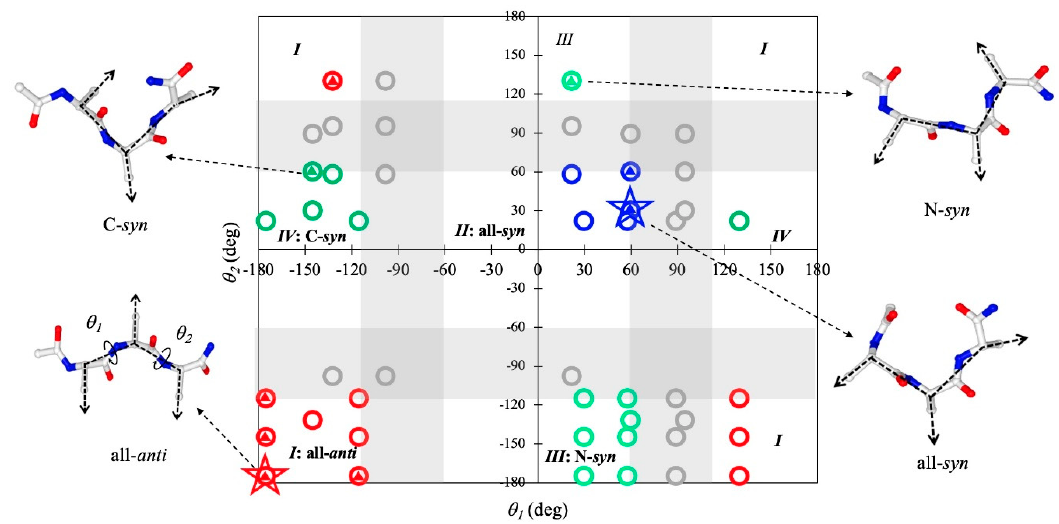
Figure 2. Orientations of sidechains for all the 48 possible conformational states of a tripeptide. The middle plot shows the rotational angles ( θ 1 and θ 2 ) of sidechains for each conformational state. The blue, red, light green, and green circles denote all- syn , all- anti , N- syn , and C- syn conformations, respectively, and the gray circles denote the conformations with 60°<| θ 1 or θ 2 |<115°. The conformations that were observed with a probability of >5% for at least one sequence are labeled with triangles. The βββ and a R a R β conformations are labeled with stars.